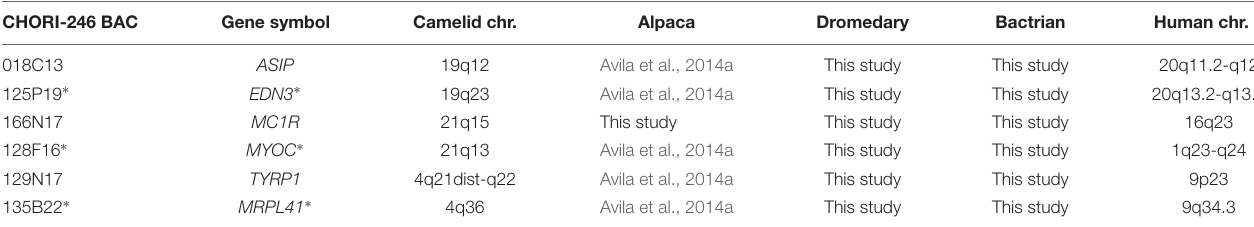
TABLE 3 | Comparative cytogenetic mapping of ASIP , MC1R, and TYRP1 . CHORI-246 BAC Gene symbol Camelid